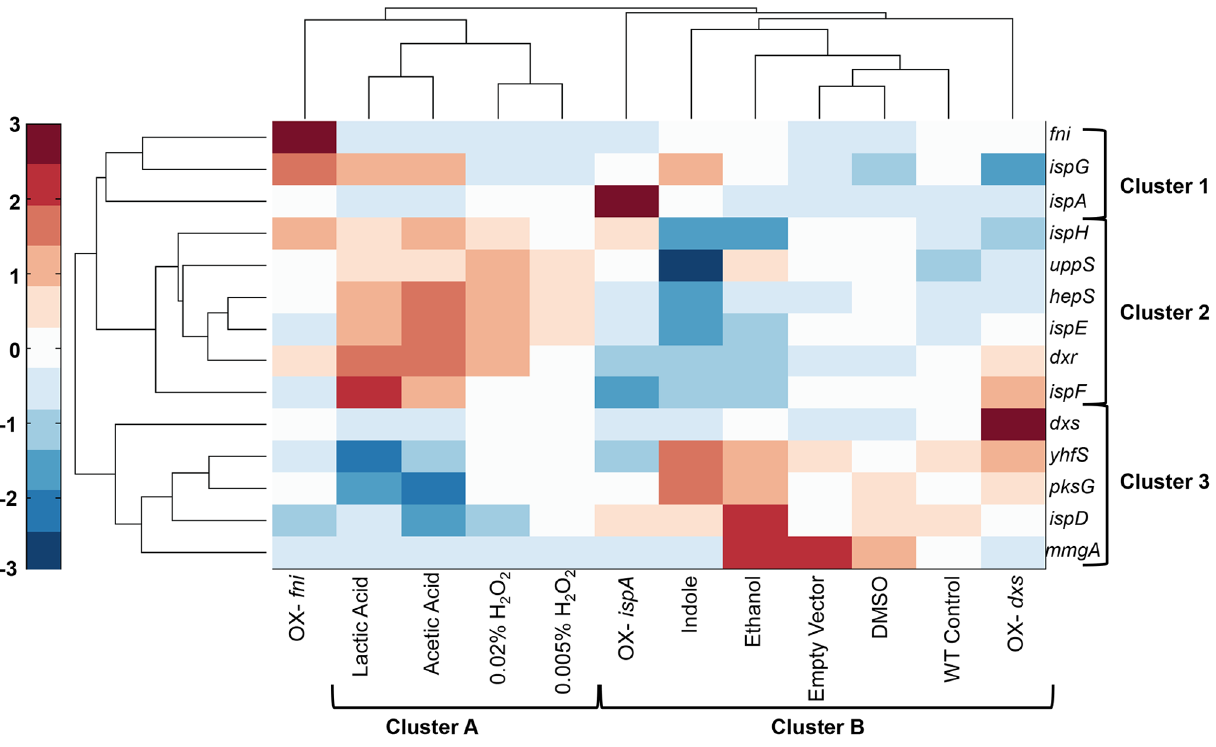
Figure 3. The terpenoid genes cluster into three main groups with respect to coexpression and into two main groups with respect to perturbations. Two-dimensional hierarchical clustering of the terpenoid genes against isoprene production in the investigated environmental and genetic perturbations in B. subtilis .